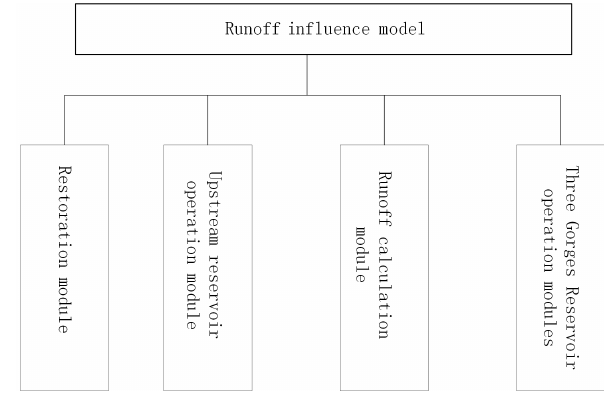
Figure 3. Diagram of Model